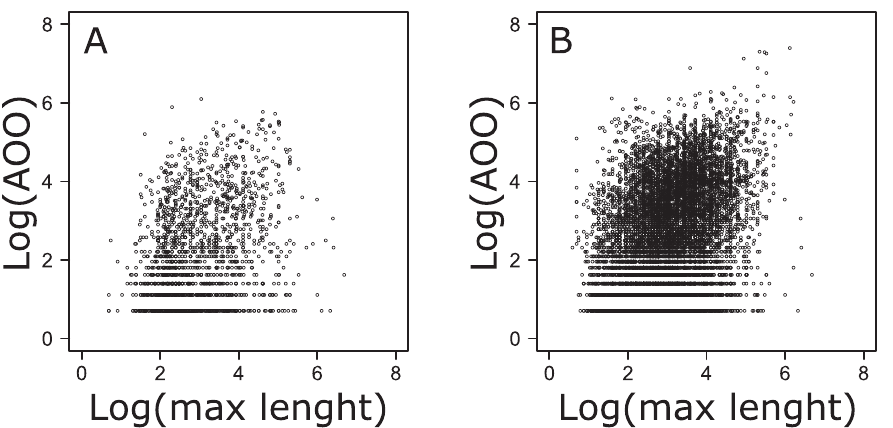
Figure 6. Relationship between fish species maximum body length and area of occupancy (AOO). Both variables are logarithmically transformed (A: freshwater dataset; B: marine dataset).